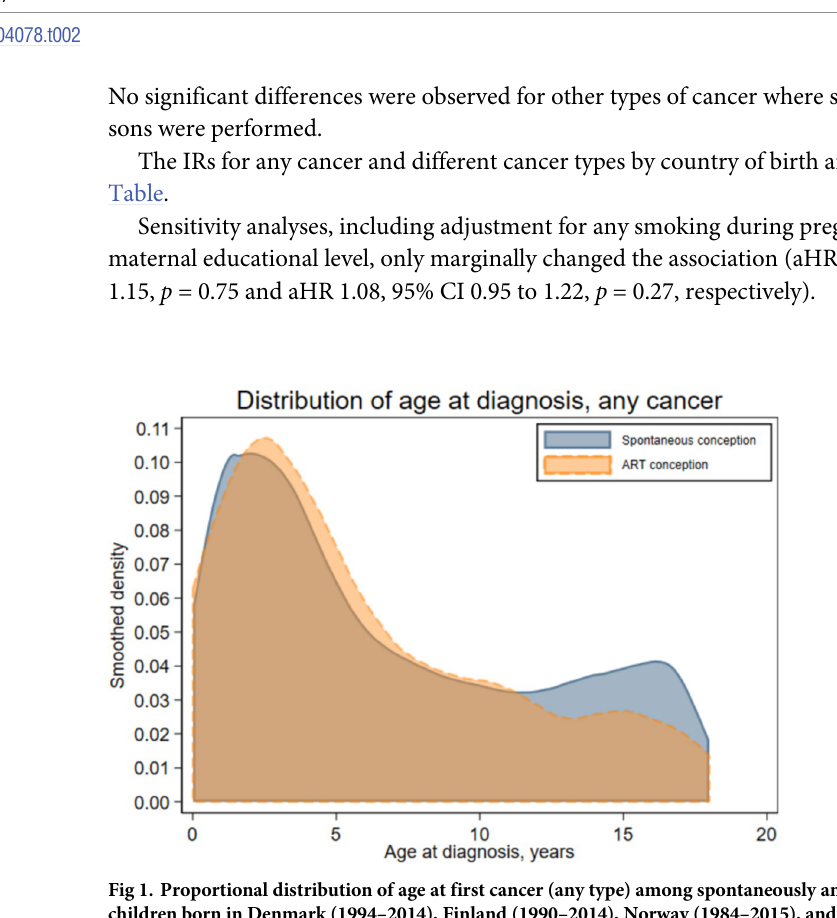
Fig 1. Proportional AU : AbbreviationlistshavebeencompiledforthoseusedinFigs 1 (cid:0) 5 andTables 2 (cid:0) 4 : Pleaseverifythatallentriesarecorrect : distribution of age at first cancer (any type) among spontaneously and ART-conceived children born in Denmark (1994–2014), Finland (1990–2014), Norway (1984–2015), and Sweden (1985–2015) and diagnosed with cancer before age 18 years. ART, assisted reproduction